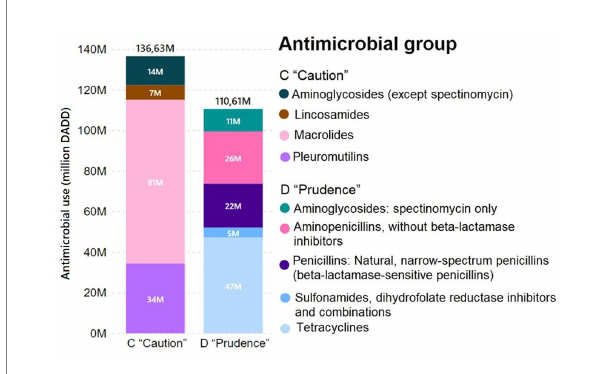
FIGURE 2 Total AM treatments in the Danish pig sector in 2020, measured as million DADD and divided according to AMEG classifications and AM class. The four AM classes of amphenicols, some penicillins (anti- staphylococcal penicillins, ß-lactamase-resistant penicillins), 3rd and 4th generation cephalosporins and polymyxins were excluded from the graph, as each class constituted less than 1% of the